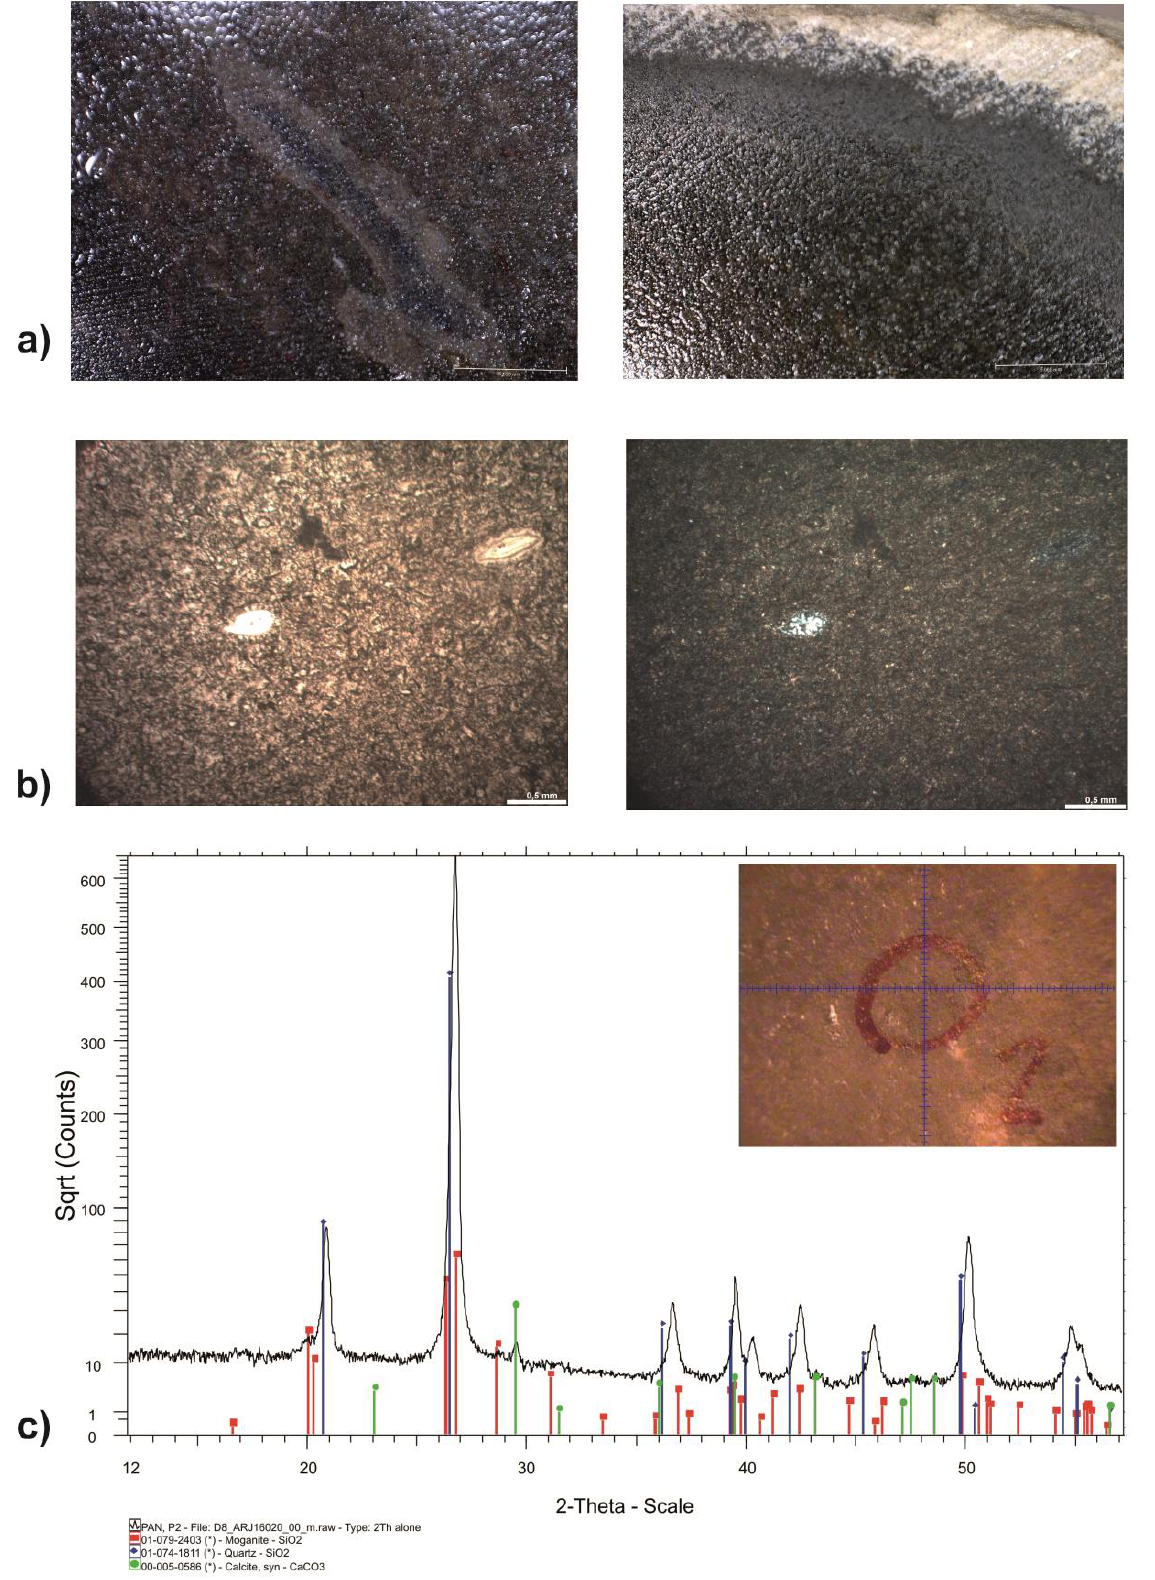
Figure 8. a) Macroscopic features of Oligocene cherts, with opaque appearance and calcareous cortex. b) Thin sections show a high percentage of carbonates, microquartz and replaced microfossils. c) μ-XRD confirming the presence of silica (moganite & quartz) and